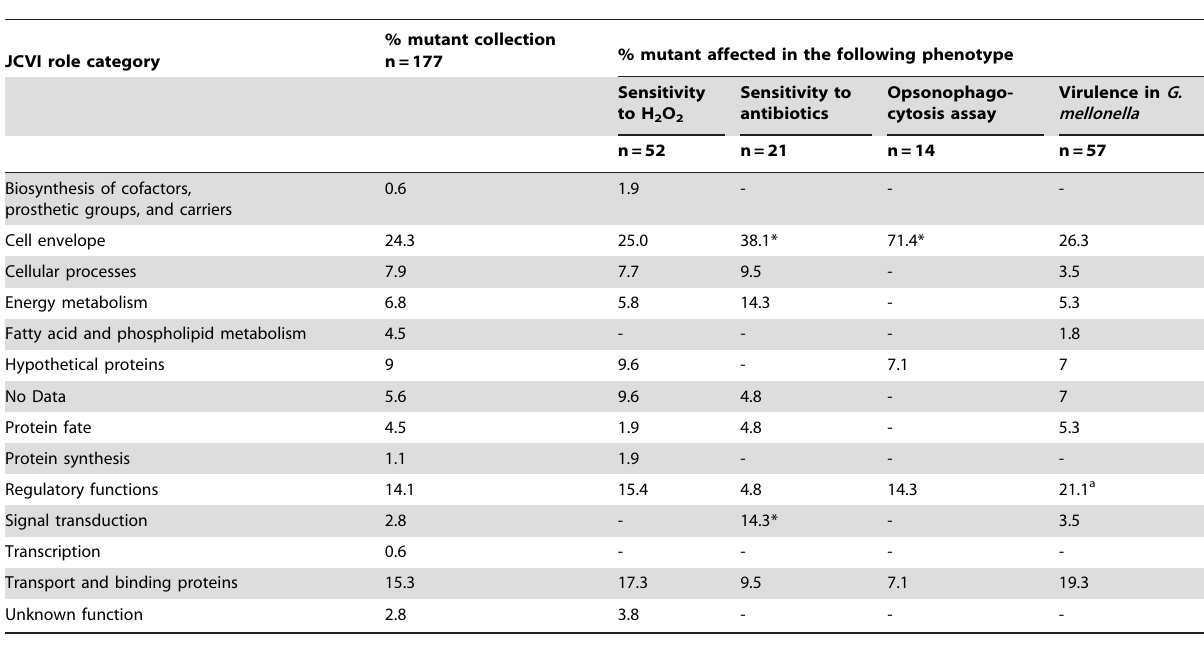
Table 1. Percentage of mutants in each JCVI role